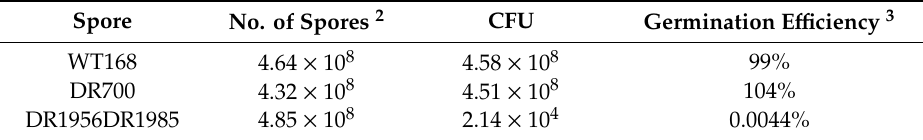
Table 2. Germination e ffi ciency of the B. subtilis spores on LB plate